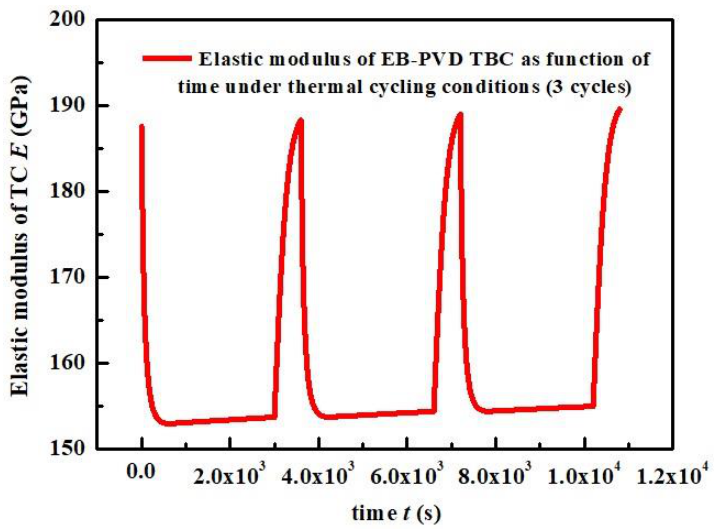
11 of 30 Figure 6. The variation of elastic modulus during high-temperature dwell period due to sintering. It is difficult to measure elastic modulus during the thermal cycling process. There- fore, in the present study, it is assumed that an increase in elastic modulus during cooling follows the same pattern as that of the elastic modulus upon heating. Additionally, within the dwell period during thermal cycling, elastic modulus is affected by high-temperature sintering. During a thermal cycling period, as the duration of both heating and cooling processes is much shorter than a high-temperature dwell period, the effect of sintering on modulus changes can be neglected for the heating/cooling process [15]. To simulate changes in elastic modulus versus temperature T during thermal cycling, the experimentally measured moduli in [39] are formulated and then fitted approximately by (21) where  ,  and  are fitting parameters with  = 132.27,  = 814.8 K and  = 1574.48 K. E 0 (t) is a process-dependent modulus of TC estimated from isothermal sintering at the end of the high-temperature thermal cycle using Equation (20). The temperature-process-de-